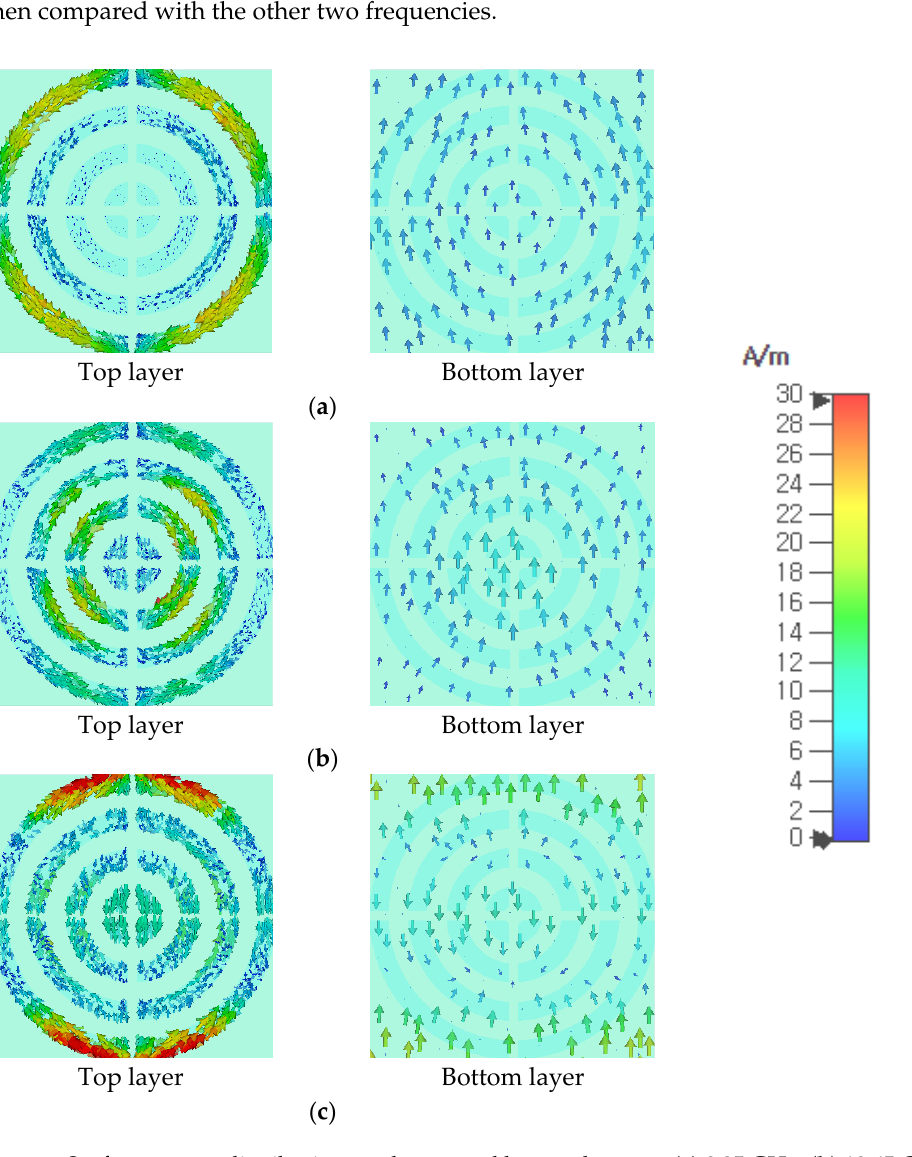
Figure 3. Surface current distributions at the top and bottom layers at ( a ) 8.35 GHz, ( b ) 18.65 GHz, and ( c ) 21.65 GHz.